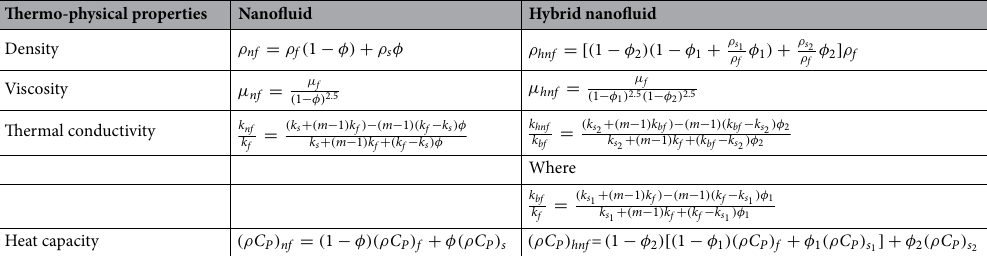
Thermo-physical properties